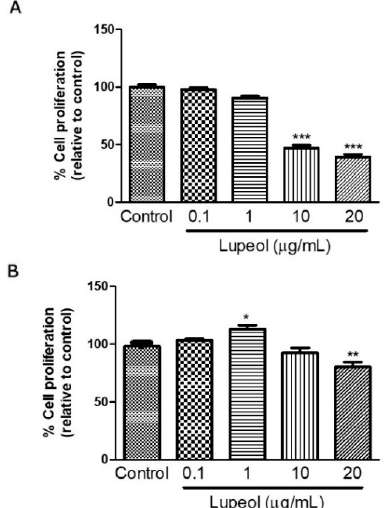
Figure 1. Cell proliferation of ( A ) epidermal keratinocytes and ( B ) dermal fibroblasts in response to lupeol. Cells were seeded in a 96-well plate. After overnight attachment, different concentrations of lupeol were added, and the cells were left for 24 h at 37 °C. Cell proliferation was measured by crystal violet assay and calculated by a comparison of the values from the lupeol treatment group with the control group. Data are expressed as mean ± standard error of the mean (SEM). * p < 0.05, ** p < 0.01, and *** p < 0.001 versus control group. Molecules 2018 , 23 , x